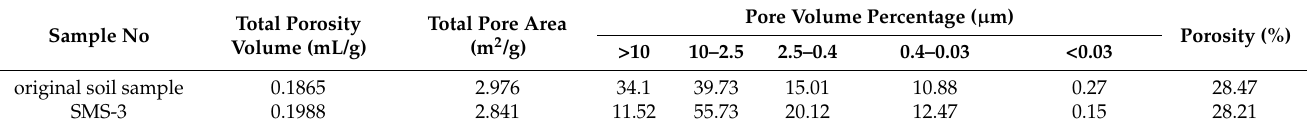
Table 4. Characteristic parameters of pore structure of mercury intrusion